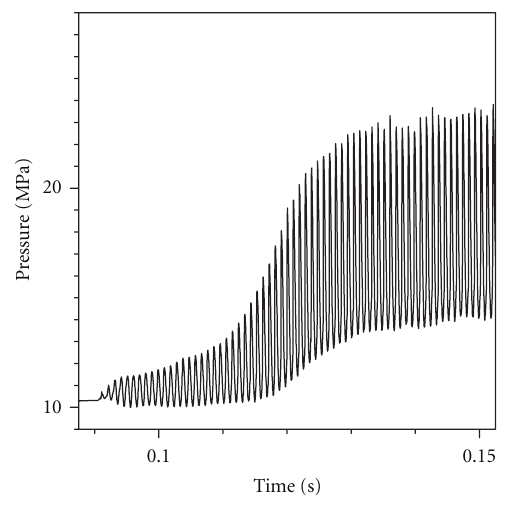
Figure 8: Predicted head-end pressure-time profile, reference motor ( K b = 20000 s − 1 , Δ H s = 150000 J/kg, Δ p d = 2atm, α p = 0%), acceleration active, no particles.